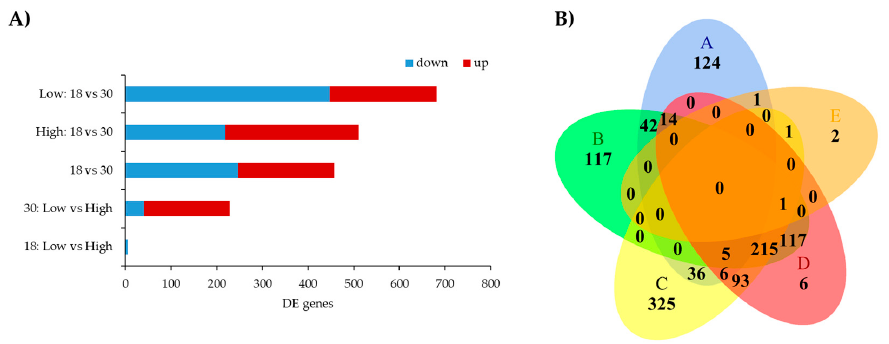
Figure 2. Differentially expressed genes in Hanwoo’s muscle at different ages. ( A ) The number of differentially expressed genes in each contrast (FDR adjusted p -value < 0.05 and log 2 FC ≥ 1.5). ( B ) Venn diagram of the number of DE genes shared among the contrasts. (A) 30: Low vs. High; (B) High 18 vs. 30; (C) Low 18 vs. 30; (D) 18 vs. 30; and (E) 18: Low vs. High. In samples at 18 months old, we found five DE genes (Table 2; Figure 3), all of them down- regulated in animals with Low MS: Solute carrier family 38 member 4 ( SLC38A4 ), ATP binding